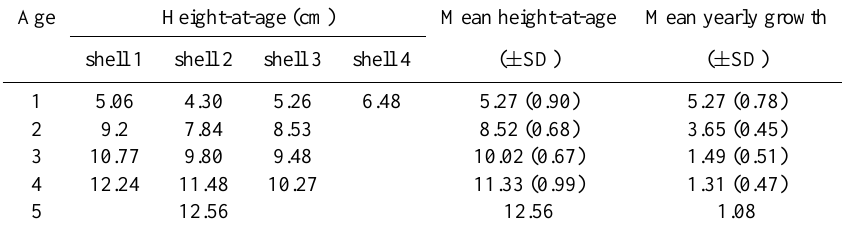
Table 3. Height-at-age (cm) and growth of each age class of E. directus shells.